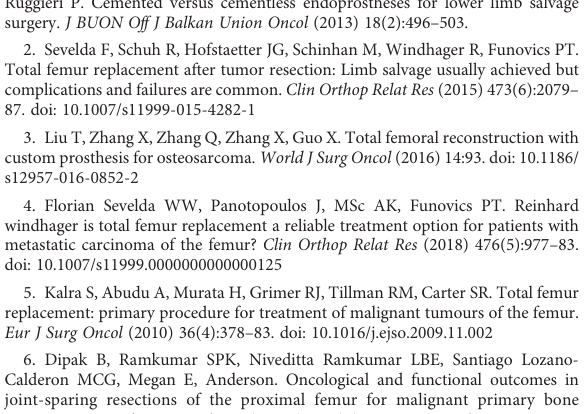
SUPPLEMENTARY FIGURE 1 (A) Finite element analysis of cancellous bone stress distribution after straight stem reconstruction. a) Residual proximal femur; b) Residual proximal femur coronal plane. (B) Finite element analysis of cancellous bone stress distribution after curved stem reconstruction. a) Residual proximal femur; b) Residual proximal femur coronal